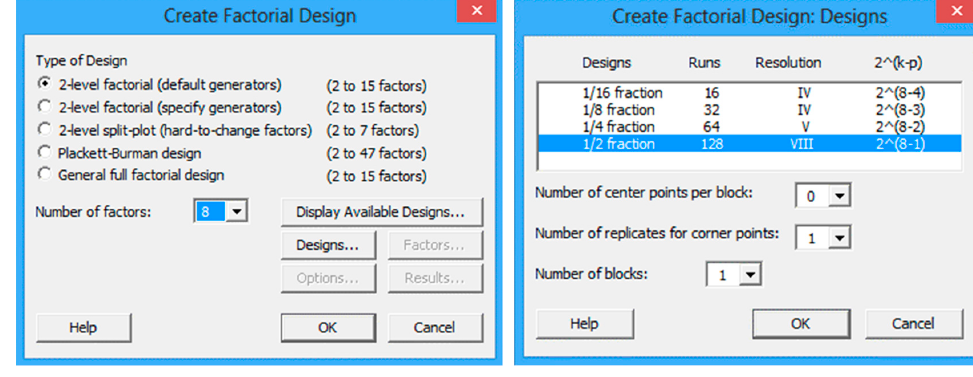
Figure 3. Creation of factorial design. Table 4. Experimental plans and output response.